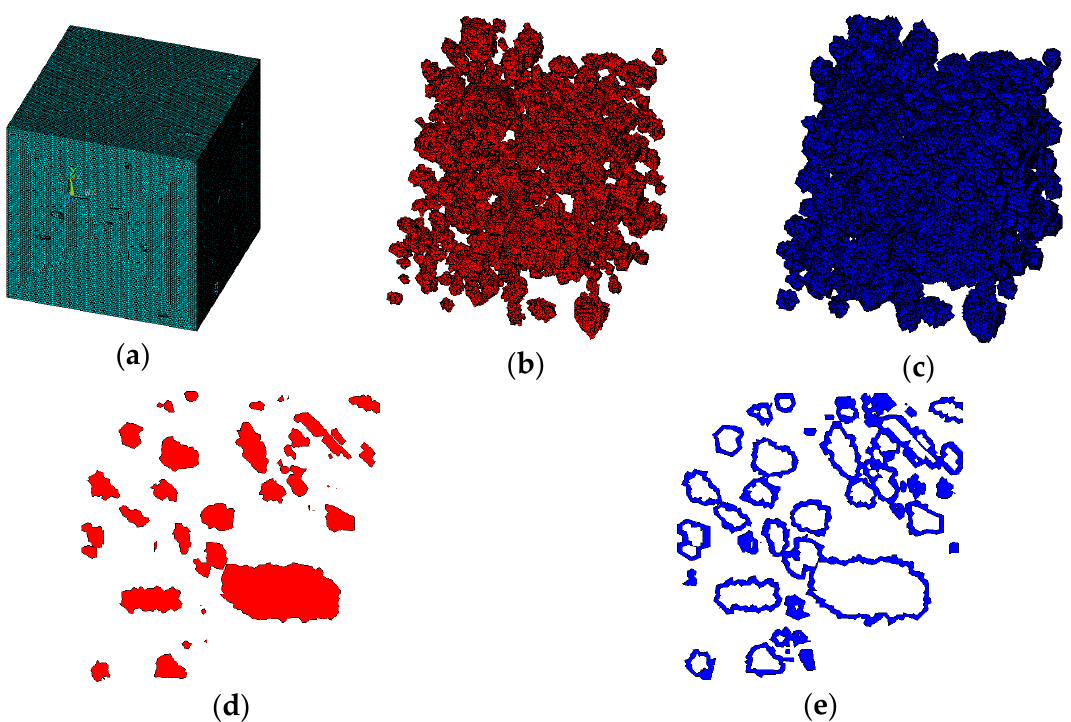
Figure 3. Mesh diagram of mortar, aggregate and ITZ elements in polyhedral aggregate model, ( a ) Mortar elements, ( b ) aggregate elements, ( c ) ITZ elements, ( d ) Aggregate elements on the profile, ( e ) ITZ elements on the profile.